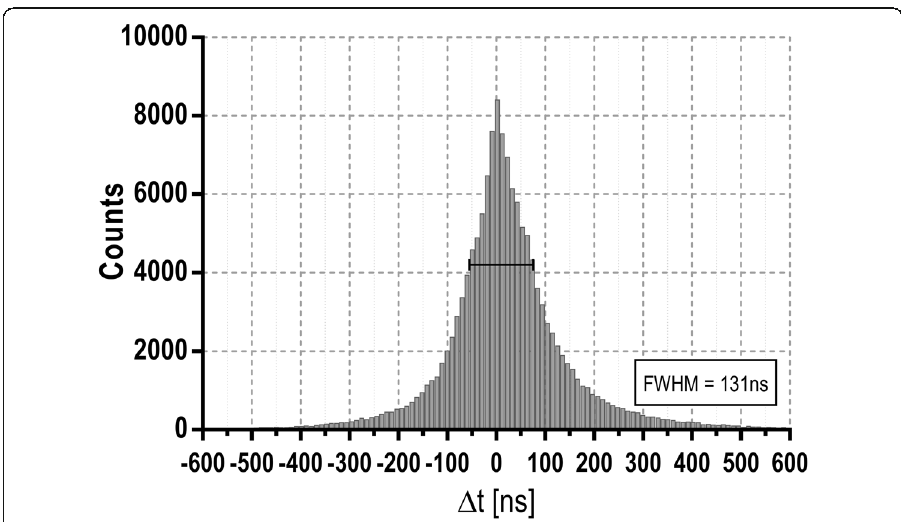
Fig. 3 Time difference histogram obtained with the detector using 18 F for a 1-min acquisition with an energy window of 350 – 700 keV leading to a CRT of 131 ns